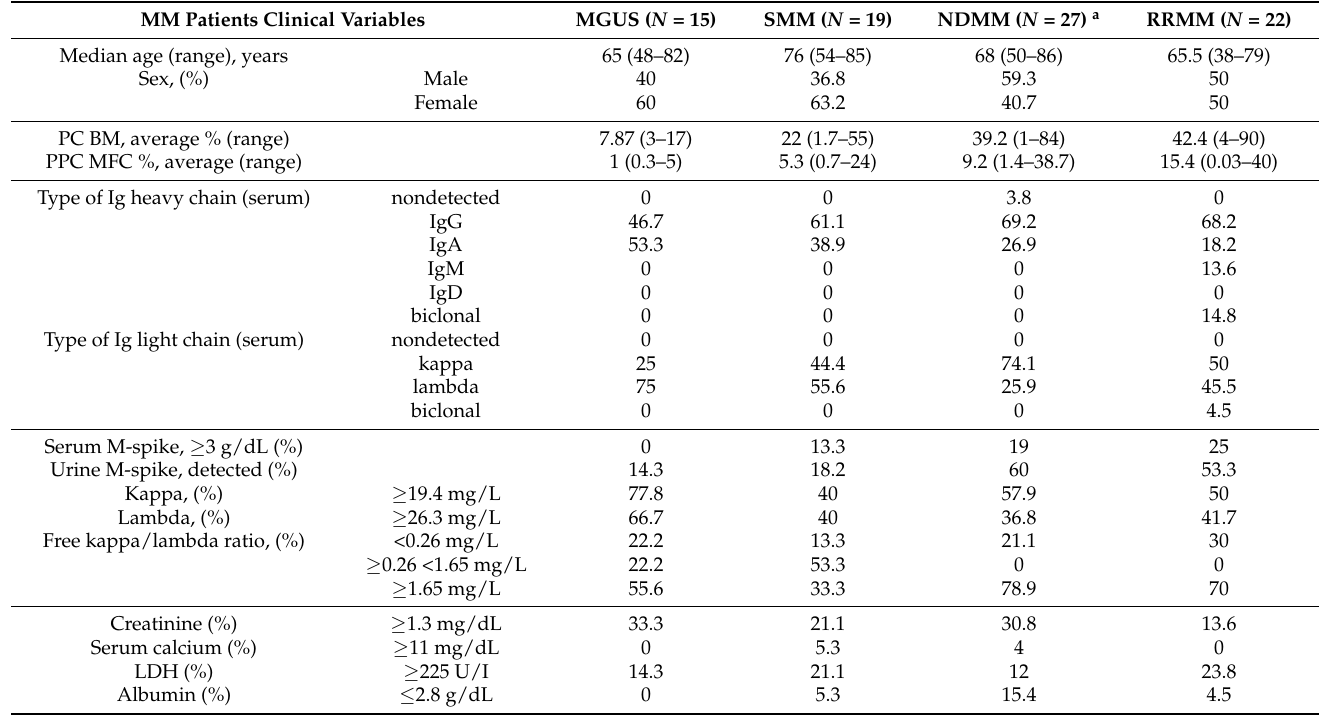
Table 1. Main characteristics of multiple myeloma (MM) patients included in the study ( N = 83). MM Patients Clinical